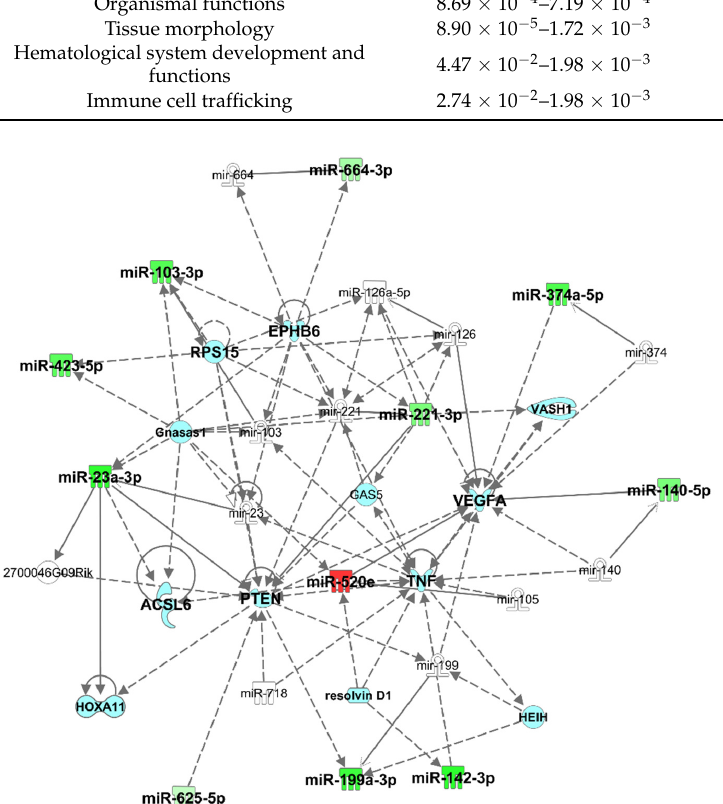
Figure 1. Top network identified by Ingenuity Pathway Analysis (IPA) for chronic mild traumatic brain injury (mTBI) versus control: Connective Tissue Disorders, Inflammatory Disease, and Organismal Injury and Abnormalities. Green indicates genes that are downregulated, and red indicates genes that are upregulated, where increased color saturation represents more extreme down- or upregulated in the dataset. Solid lines represent direct interactions, nontargeting interactions, or correlations between chemicals, proteins, or RNA. Dotted lines represented indirect interaction. Arrowed lines represent activation, causation, expression, localization, membership, modification, molecular cleavage, phosphorylation, protein–DNA interactions, protein–TNA interaction, binding regulation, and transcription. Shapes represent molecule type (double circle = complex/group; square = cytokine; diamond = enzyme; inverted triangle = kinase; triangle = phosphatase; oval = transcription regulator; trapezoid = transporter; circle = other). Reprinted from Ingenuity Pathway Analysis under a CC BY 4.0 license, with permission from QIAGEN Silicon Valley, original copyright 2000-2021.